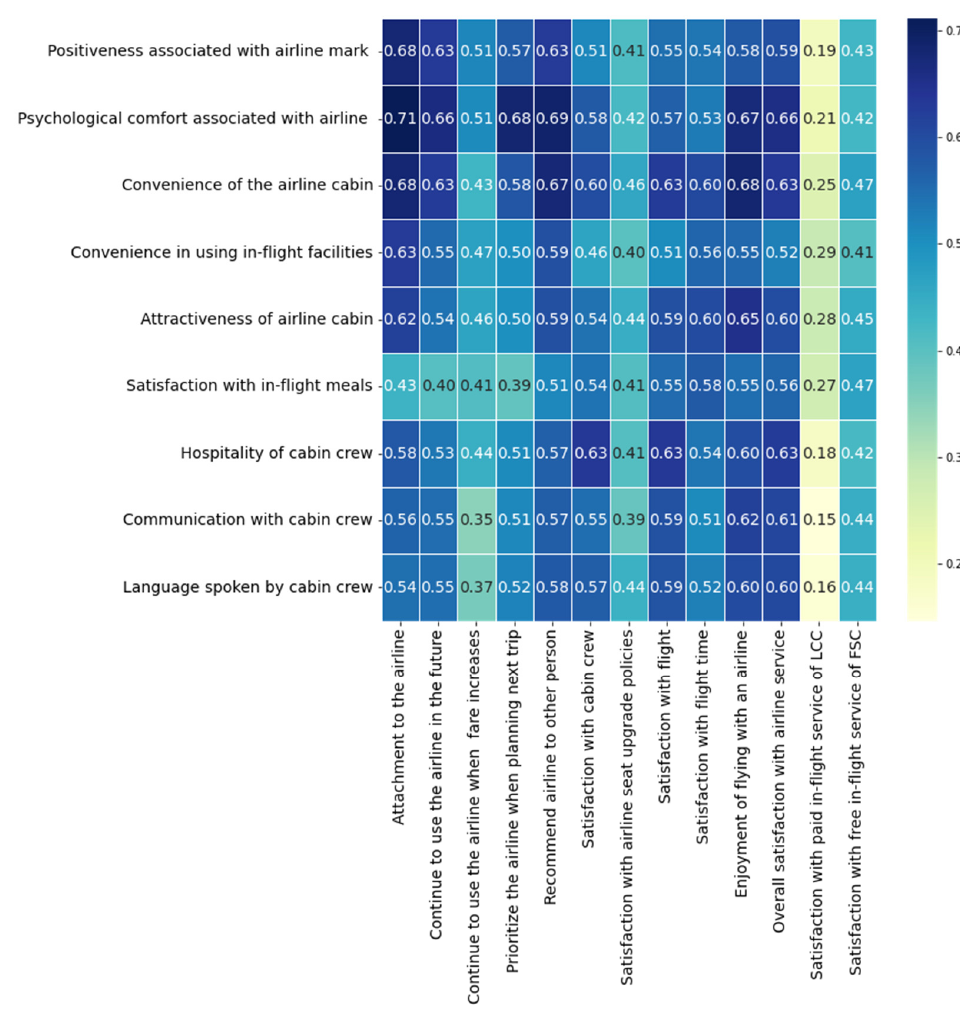
Figure 4. Correlation matrix between brand experience factors and customer churn risk and customer satisfaction factors.